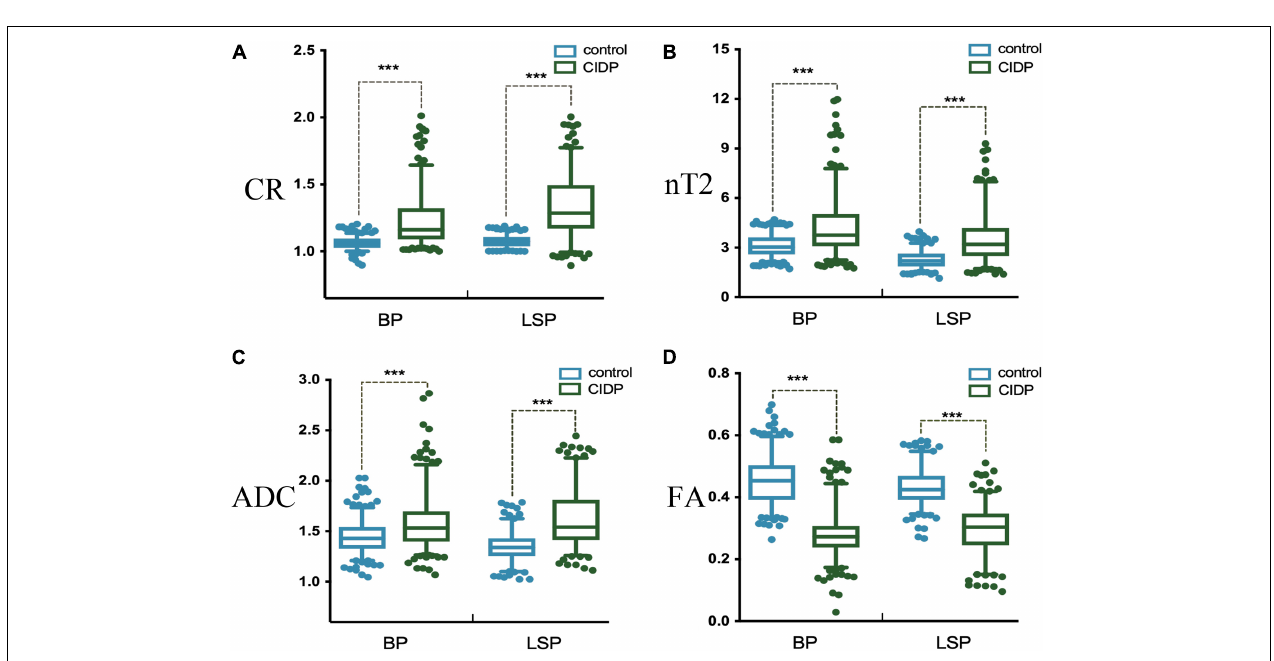
FIGURE 3 | Diffusion tensor tractography (DTT) of healthy control and CIDP patients shows the bundles of plexus nerve fiber and their branches in three-dimensional views. Tractography shows thickened, partially discontinuous, and distorted fiber tracts of the brachial and lumbosacral plexus and their branches in patients with CIDP. A, anterior view; P, posterior view; A–L, left-frontal oblique view. The main dominant direction of diffusion is color-coded (blue: z -axis = nerve course; red: x -axis (left/right); green: y -axis (up/down).